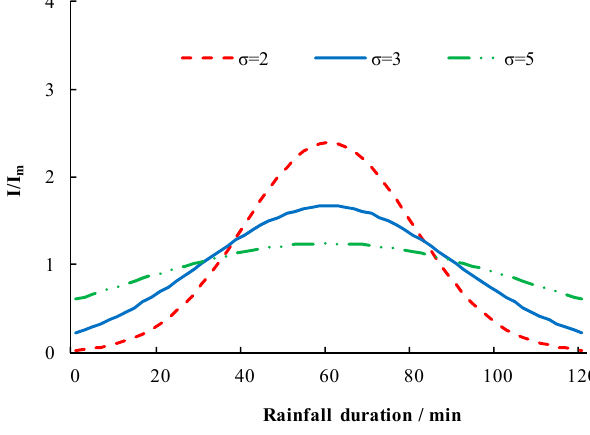
ff erent standard deviations over